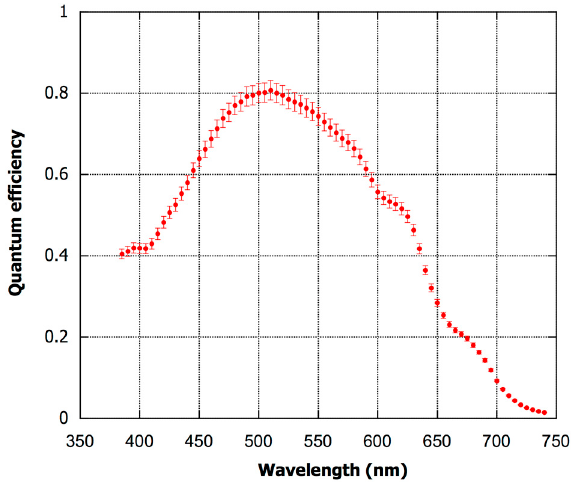
Figure 5. Spectral response of the photodiodes. Symbols and bars refer, respectively, to the averaged values and to the standard deviations measured over 5 photodiodes.